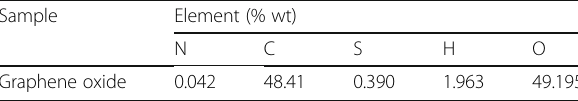
Table 1 Results of chemical analyses of graphene oxide